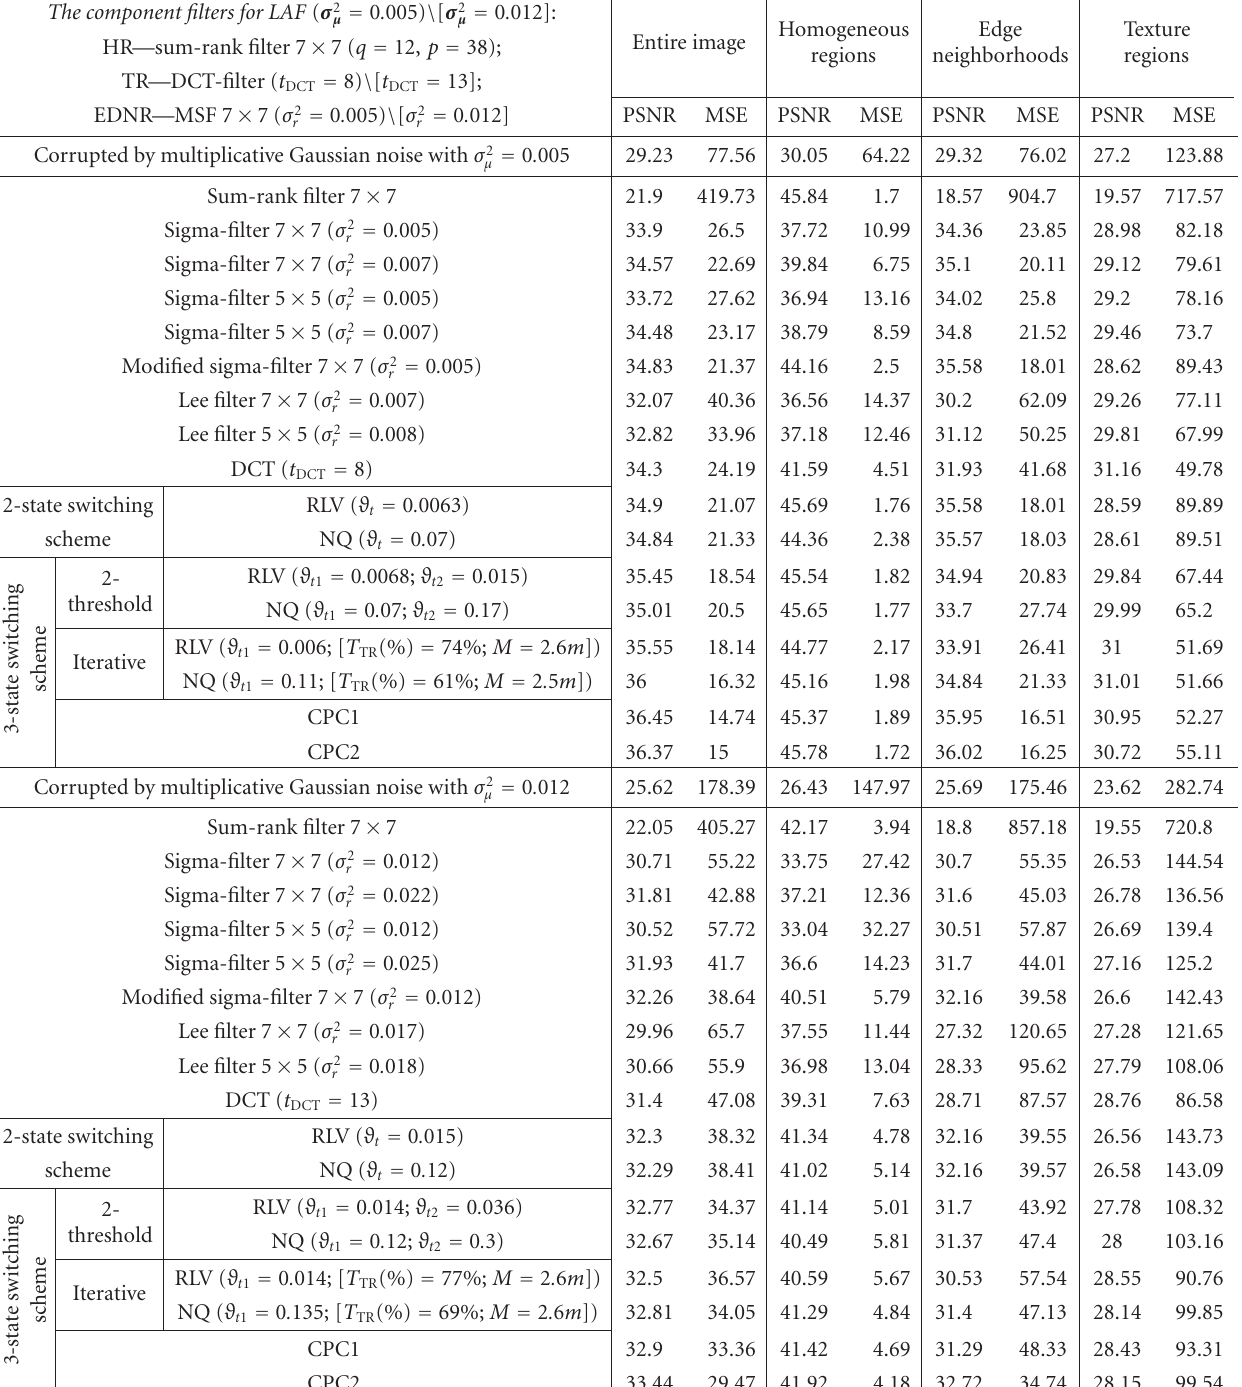
Table 2: Aggregate and local MSE and PSNR values for nonadaptive and locally adaptive filters for the test image in Figure 1 containing four texture fragments. The multiplicative Gaussian noise with σ 2 µ = 0 . 005 and with σ 2 µ = 0 . 012 has been added to this image (see Figure 7a). The component filters for LAF ( σ 2 µ = 0 . 005) \ [ σ 2 µ = 0 . 012]: regionsHR—sum-rank filter 7 × 7 ( q = 12, p =